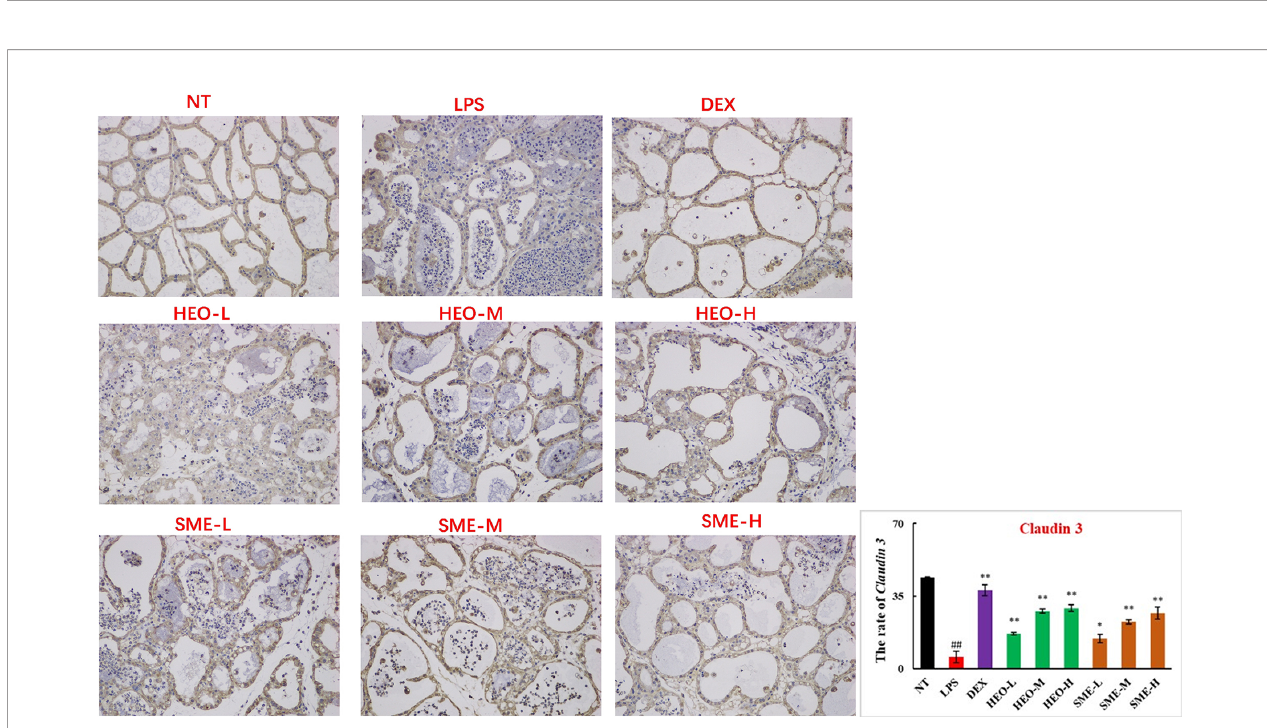
FIGURE 9 | Distribution and expression of connexin Claudin 3 in LPS-induced murine mastitis, indicated by brown or yellow colors. Mean ± SD, n= 6. ## P < 0.01 compared to blank group; * P < 0.05, ** P < 0.01 compared to model group.